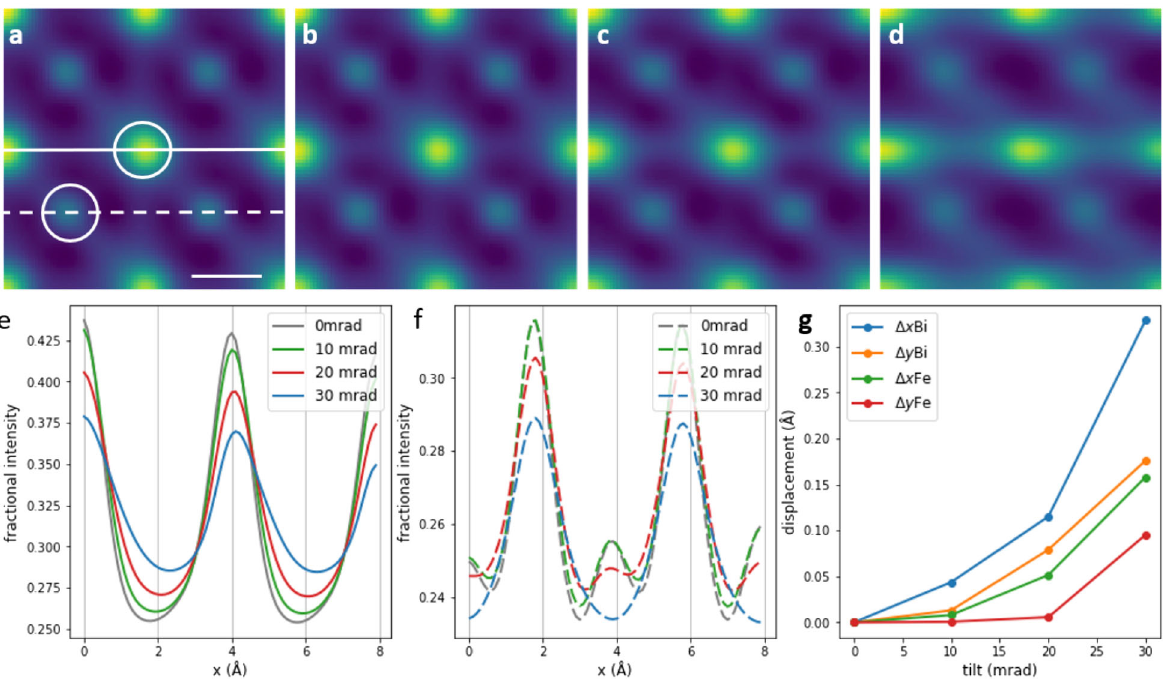
Fig. 9 Simulated ADF-STEM images of BFO. a No tilt, b 10 mrad tilt, c 20 mrad tilt, and d 30 mrad tilt. All tilts are around the y axis. Solid line on a represents position of line scans through Bi columns shown in e . Dashed line corresponds to position of line scans through Fe columns shown in f . Shifts of two atoms circled are shown relative to untilted image shown in g for both x and y shift measured using atom fi nding. The scale bar in a is 2